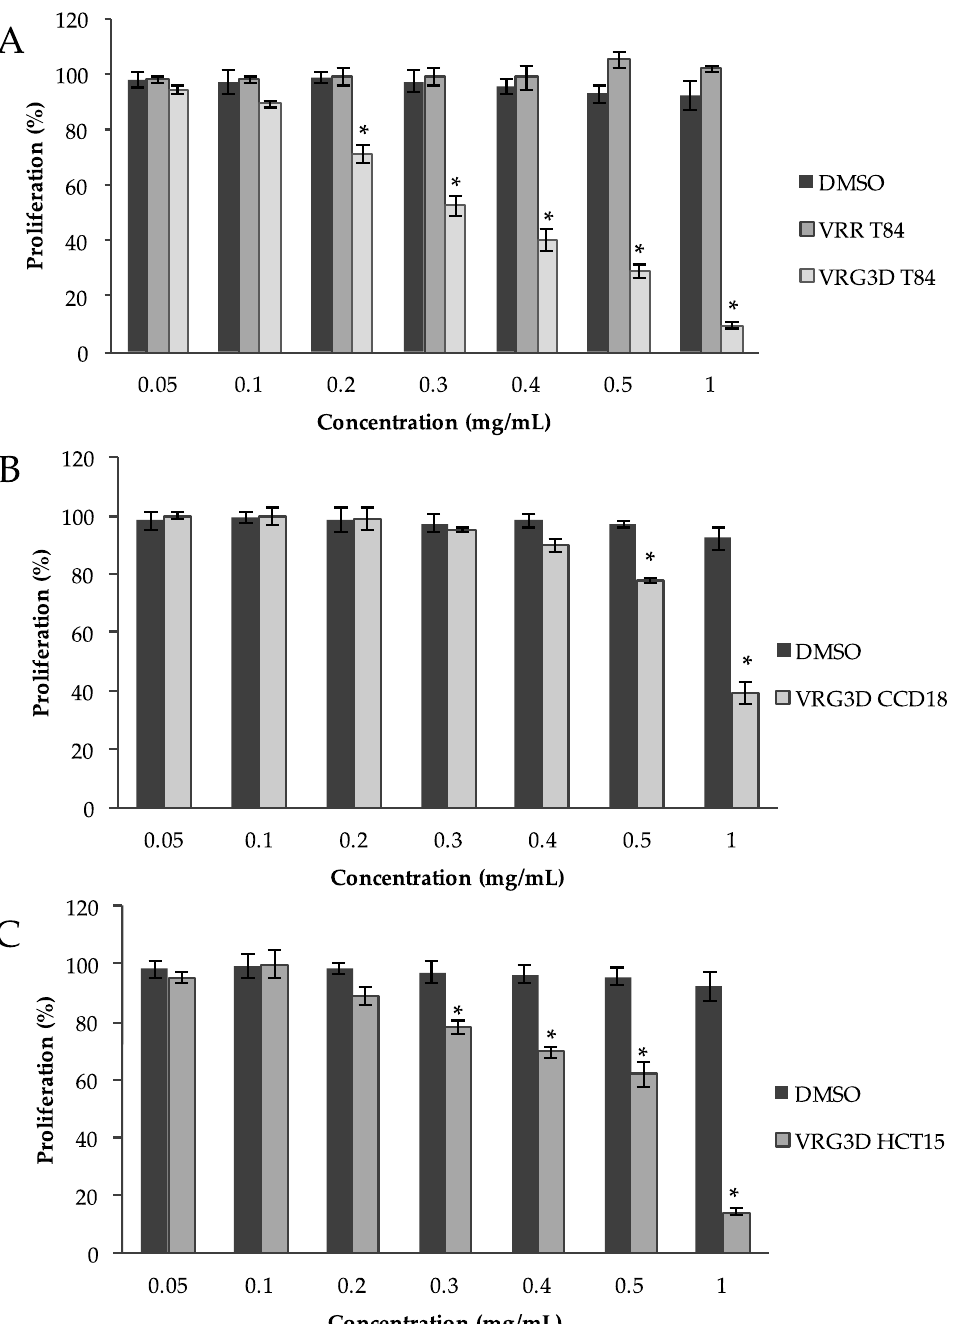
Figure 5. Proliferation assay in cell lines using 3d-germinated mung bean. ( A ) solvent DMSO, VRR and VRG3D mung bean extract in T-84 cell line; DMSO and VRG3D mung bean extract in CCD-18 cell line ( B ) and HCT-15 cell line ( C ). Results are expressed as % of cell survival and represented as means ± SEM. * indicates a significance of p < 0.05 between the treatment and control. DMSO, dimethyl sulfoxide. VRR, raw Vigna radiata . VRG3D, 3d-germinated Vigna radiata . T84, T-84 cell line. CCD18, CCD-18 cell line. HCT15, HCT-15 cell line.